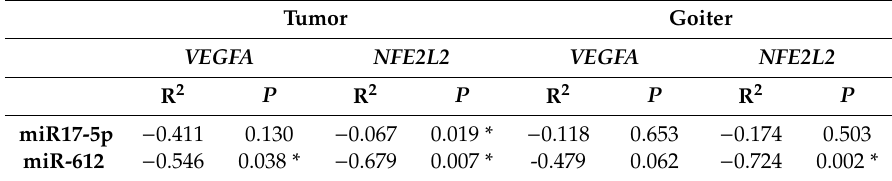
Table 4. Correlation between expression levels of VEGFA and NFE2L2 and the miR-17-5p and miR-612 miRs in thyroid tumors and colloid